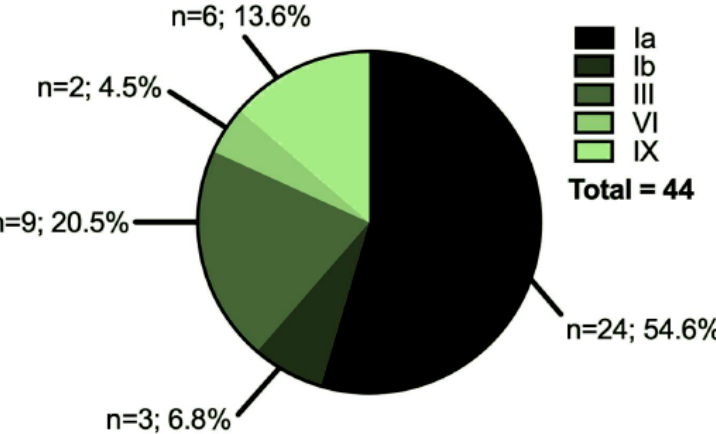
Figure 1. Composition of the GSD patient cohort. The study comprised a cohort of forty-four patients aged 2–59 years old from all over Germany. Twenty of the patients were female and twenty-four were male. 62% of patients had GSD I (Ia and Ib), while the remaining 38% had a ketotic form of hepatic